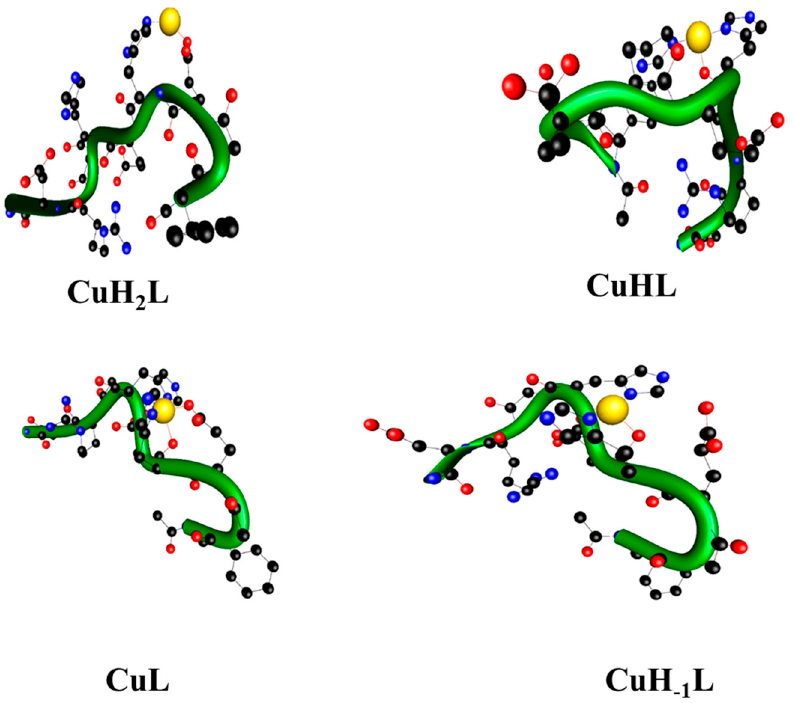
Figure 3. The structures of Ac-FGEHEHGRD-NH 2 complexes with Cu(II), where green tubes follow backbones.